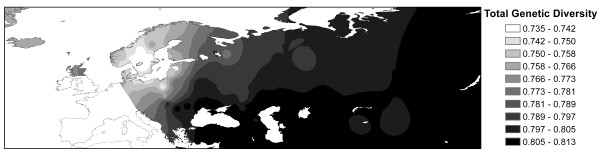
Contour synthetic map of total genetic diversity (HT) calculated for triplets of neighboring breeds. Darker shading indicates higher levels of diversity.